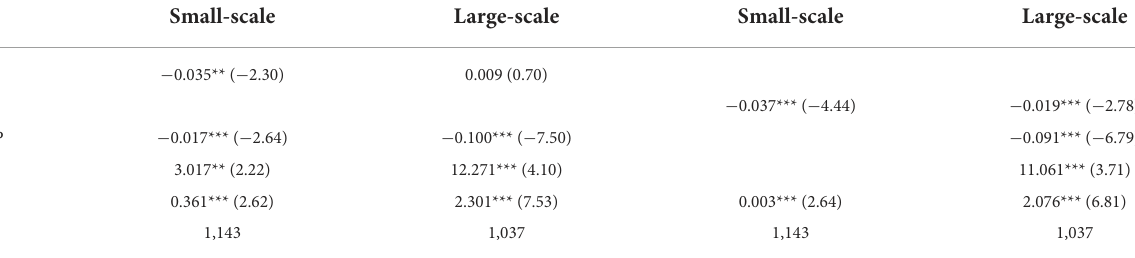
TABLE 8 The impact of firm size on market response to